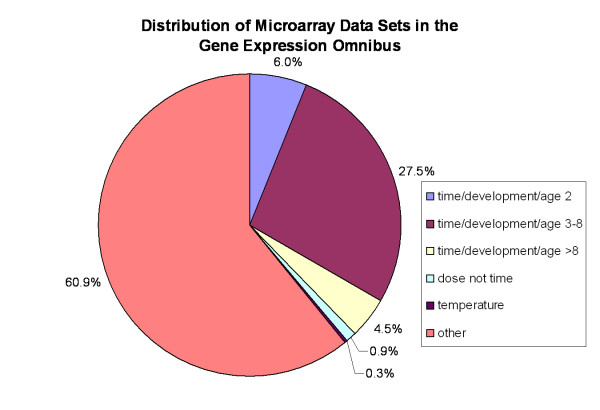
Distribution of microarray experiments by type. Summary of the 786 microarray datasets for human, mouse, rat, and yeast in the Gene Expression Omnibus as of August 2005. As can be seen, 27.5% of the sets are time series experiments with 3–8 time points. All of these sets were labeled as either time, development, or age in the database. An additional 1% percent contains other types of sequential experiments including dose or temperature response, with 3–8 different levels.